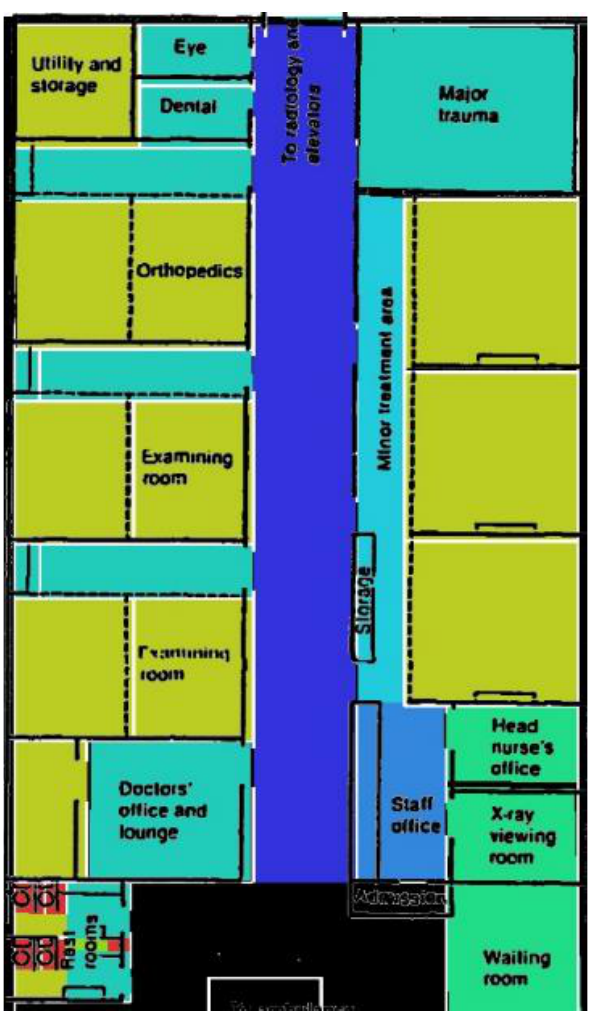
Fig. 8. Convex map analysis of corridor type emergency